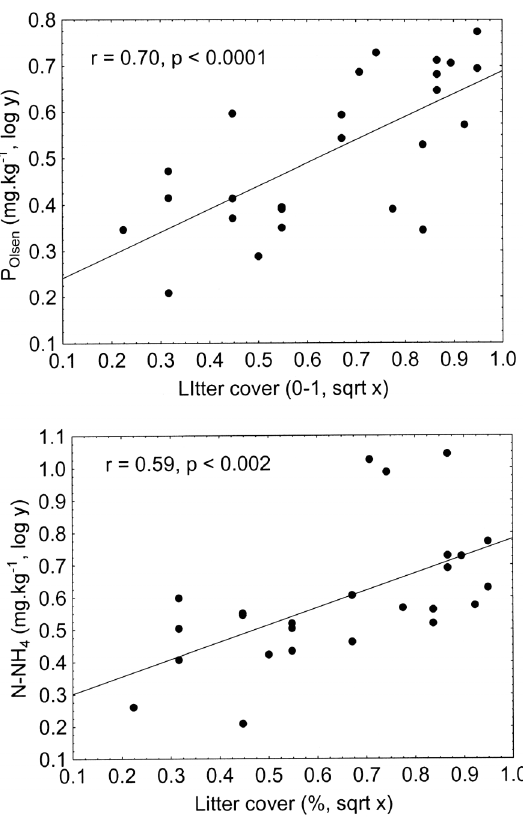
Fig 3. Scatterplots illustrating the closest linear relationships found between litter cover (%) and concentration of available P (upper graph) and available N (lower graph), in the site of south- ern